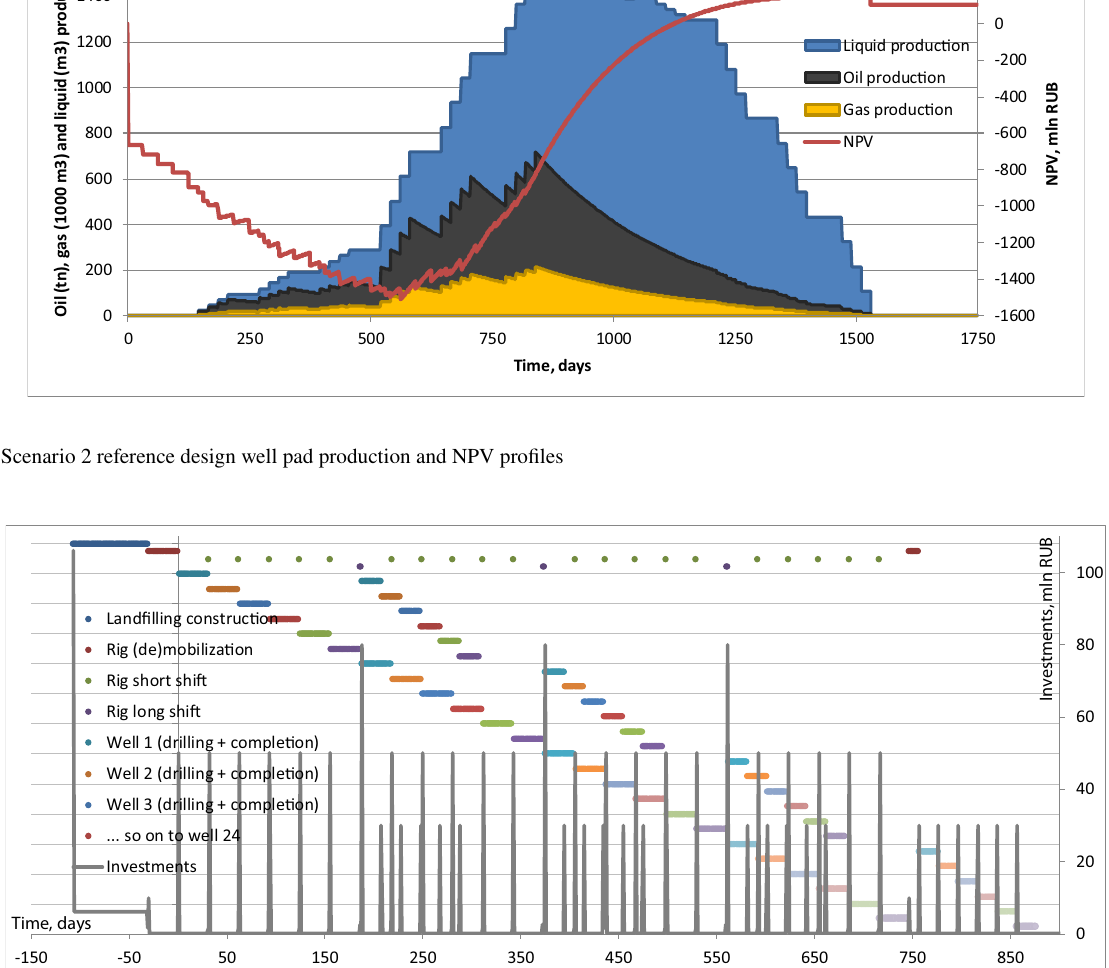
Fig. 8 Scenario 3 reference design well pad construction, drilling and completion schedule with corresponding investments (for clarification, see caption of Fig.